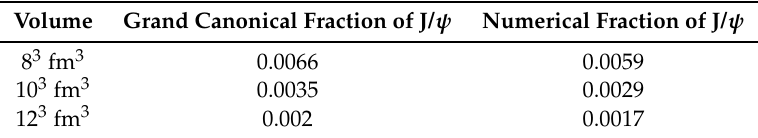
Table 1. Comparison between the fraction of bound states obtained with our simulation and that calculated by using the grand canonical partition function Volume Grand Canonical Fraction of J/